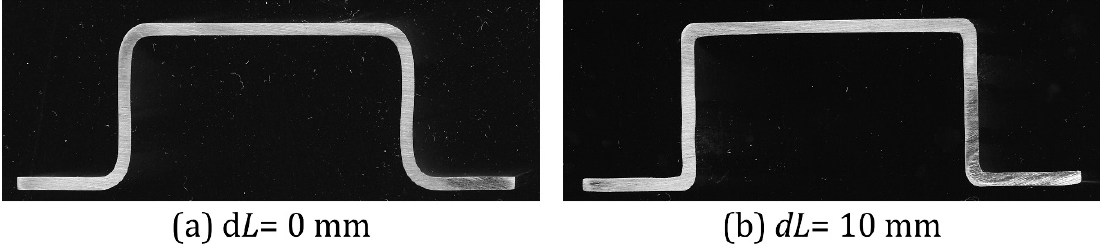
Figure 5. Cross-sections of hot hat-shaped bent parts without partial cooling for ( a ) d L = 0 mm and ( b ) d L = 10 mm. The cross-sections around the top and flange corners of the hot hat-shaped bent parts